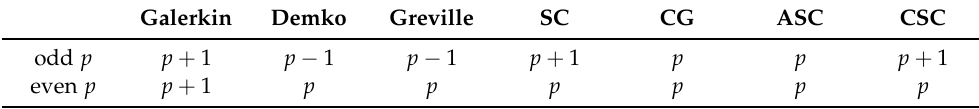
Table 3. Comparisons of orders of convergence in L 2 norm